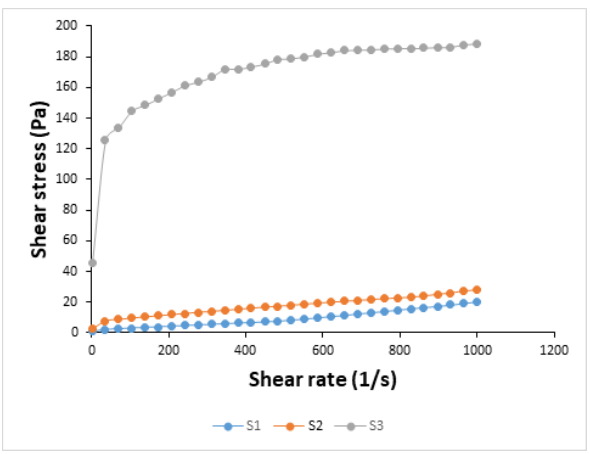
Figure 1: Shear stress dust as a function of rate of shear (sample S1: untreated phosphate dust, sample S2: calcium phosphate dust from the outside of filter and sample S3: calcium phosphate dust from the inside of